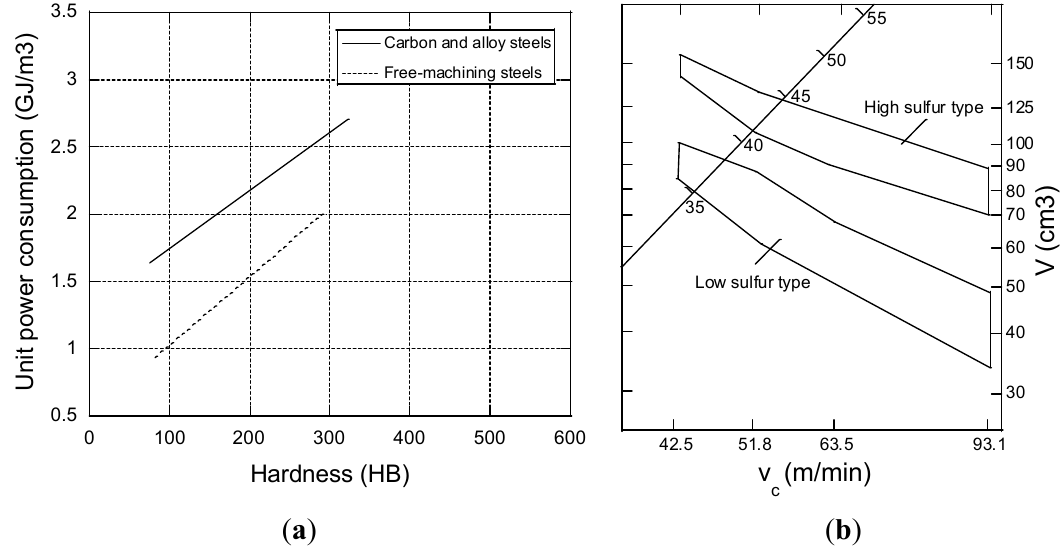
Figure 15. ( a ) Effect of sulfur content and hardness on the unit power consumption for different steel grades [44]; ( b ) Influence of sulfur content (high sulfur ~ 0.1%–0.3% S